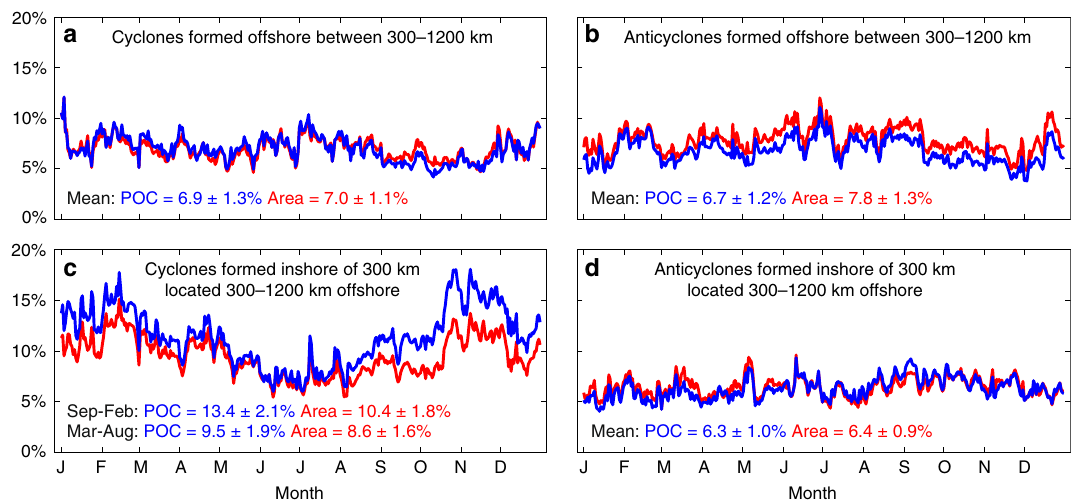
Fig. 2 Carbon content and spatial area occupied by cyclonic and anticyclonic eddies (1997 – 2010). Percentage of the total amount of surface particulate organic carbon (blue line) and the total area (red line) between 300 and 1200 km from the coast that is inside all eddies for a cyclones and b anticyclones formed offshore between 300 and 1200 km from the coast and c cyclones and d anticyclones formed inshore of 300 km and located between 300 and 1200 km